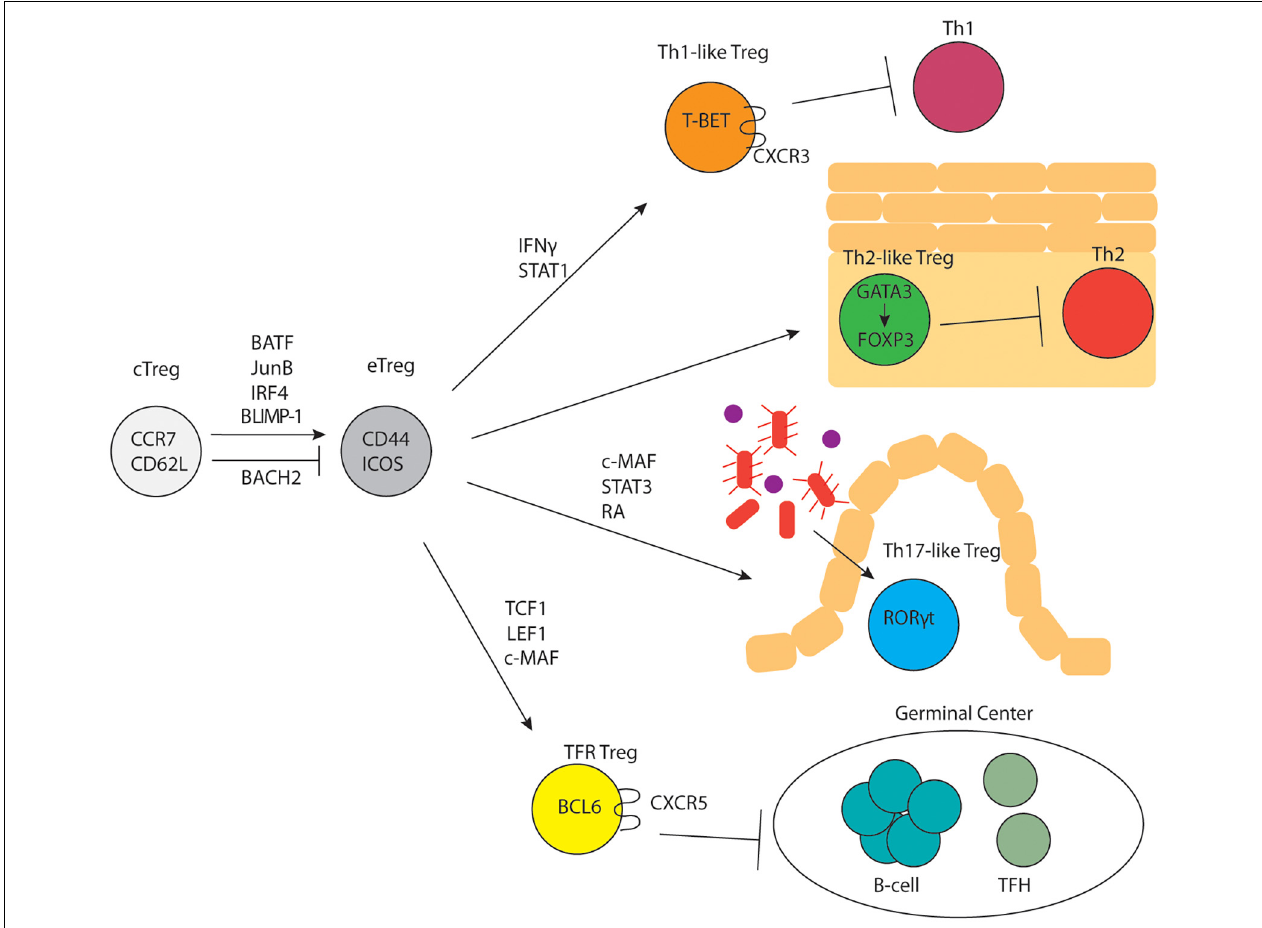
FIGURE 1 | Treg subset differentiation. cTregs differentiate into eTregs in response to TCR signaling and upregulation of specific transcription factors. eTregs undergo differentiation into subsets that parallel CD4+ T-helper cell subsets and control distinct immune